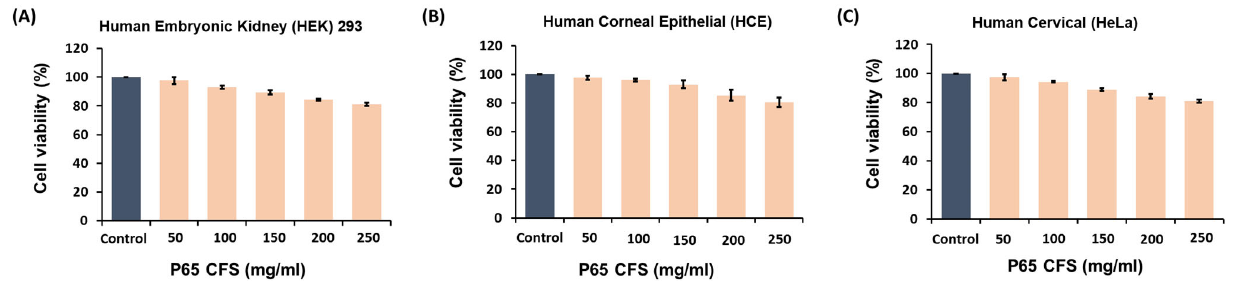
Figure 1. Cytotoxicity of the cell ‐ free supernatant of L. sakei Probio65 (P65 ‐ CFS) for human cell lines, assessed by the MTT assay. ( A ) Human embryonic kidney (HEK) 293, ( B ) human corneal epithelial (HCE), and ( C ) human cervical (HeLa) cells were used to determine the toxicity of P65 ‐ CFS in a range of increasing concentrations. Cells were seeded in 96 ‐ well plates at a density of 4 × 10 4 cells/well, then treated with P65 ‐ CFS for 24 h; the percentage of viability was determined in relation to an untreated control. Analysis of each sample was performed in triplicate, and data are represented as the means ± SD of three independent experiments.